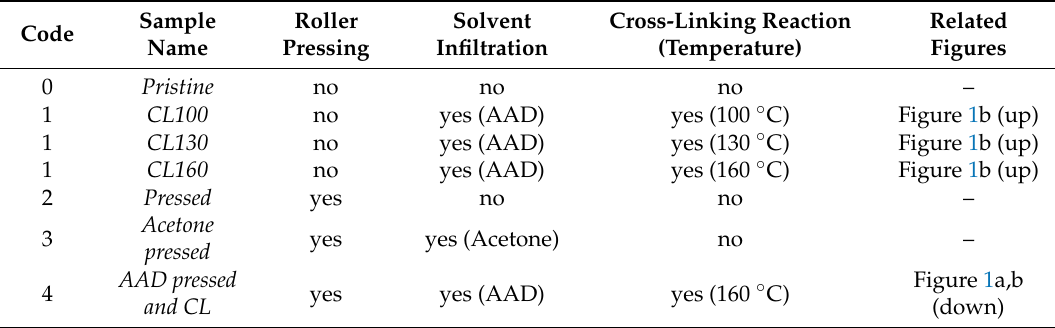
Table 1. The sample name and treated